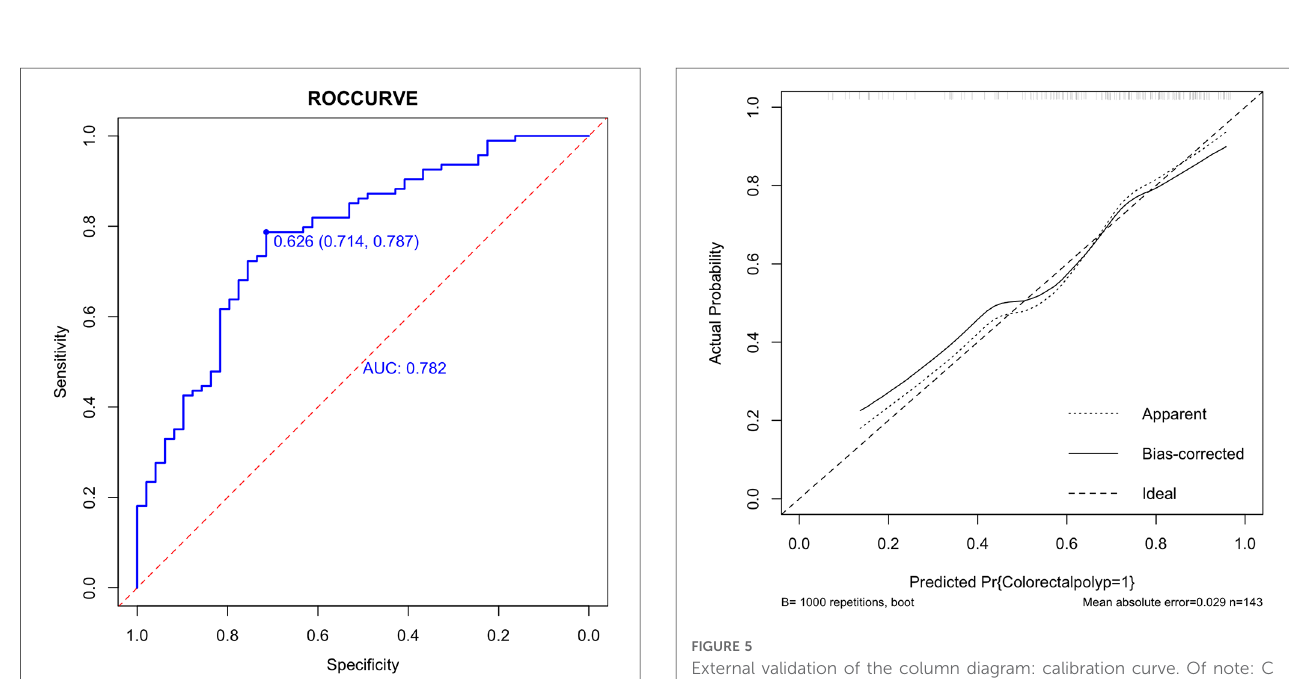
FIGURE 3 Internal validation of the column diagram: calibration curve of note: C index: 0.747.